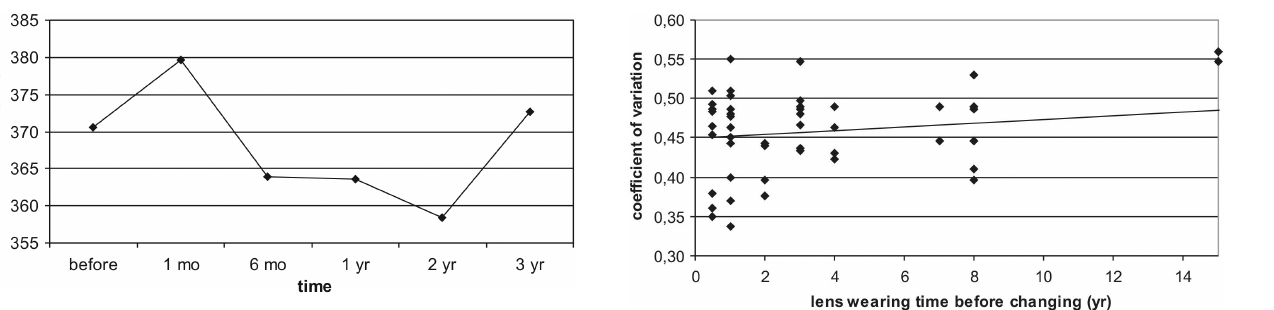
Fig. 6. The correlation between the lens wearing time and the coe±cient of variation in Group 1, direct proportion ( r ¼ 0 : 28; p ¼ 0 :